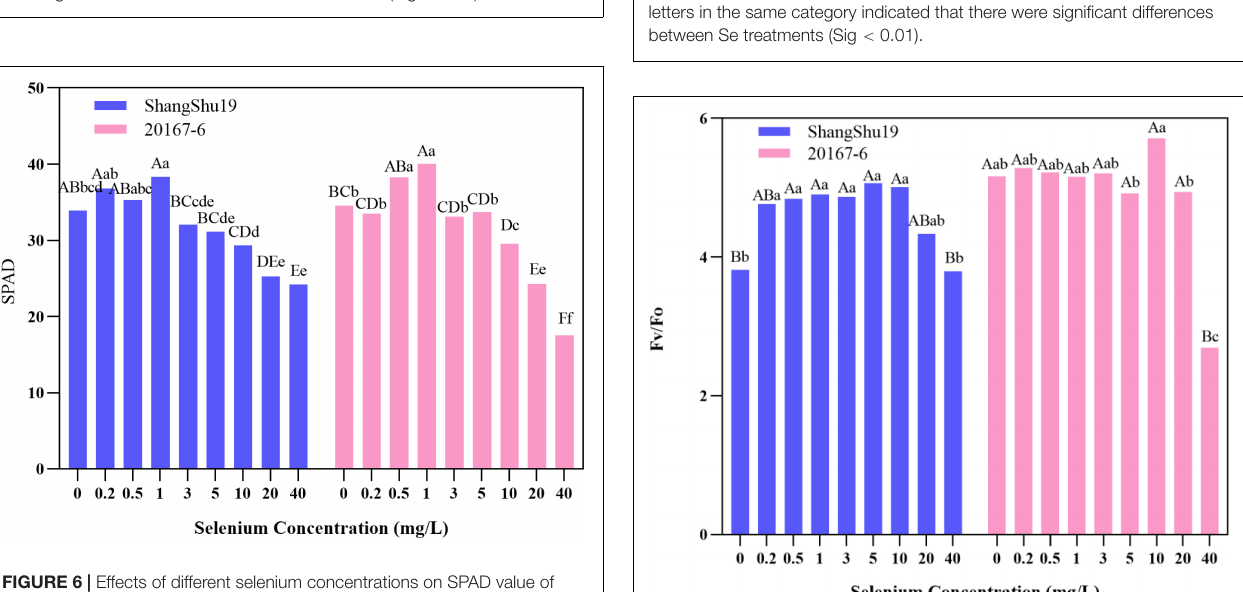
FIGURE 6 | Effects of different selenium concentrations on SPAD value of sweet potato leaves. Different lowercase letters in the same category indicated that there were significant differences between Se treatments (Sig < 0.05); Different capital letters in the same category indicated that there were significant differences between Se treatments (Sig < 0.01).